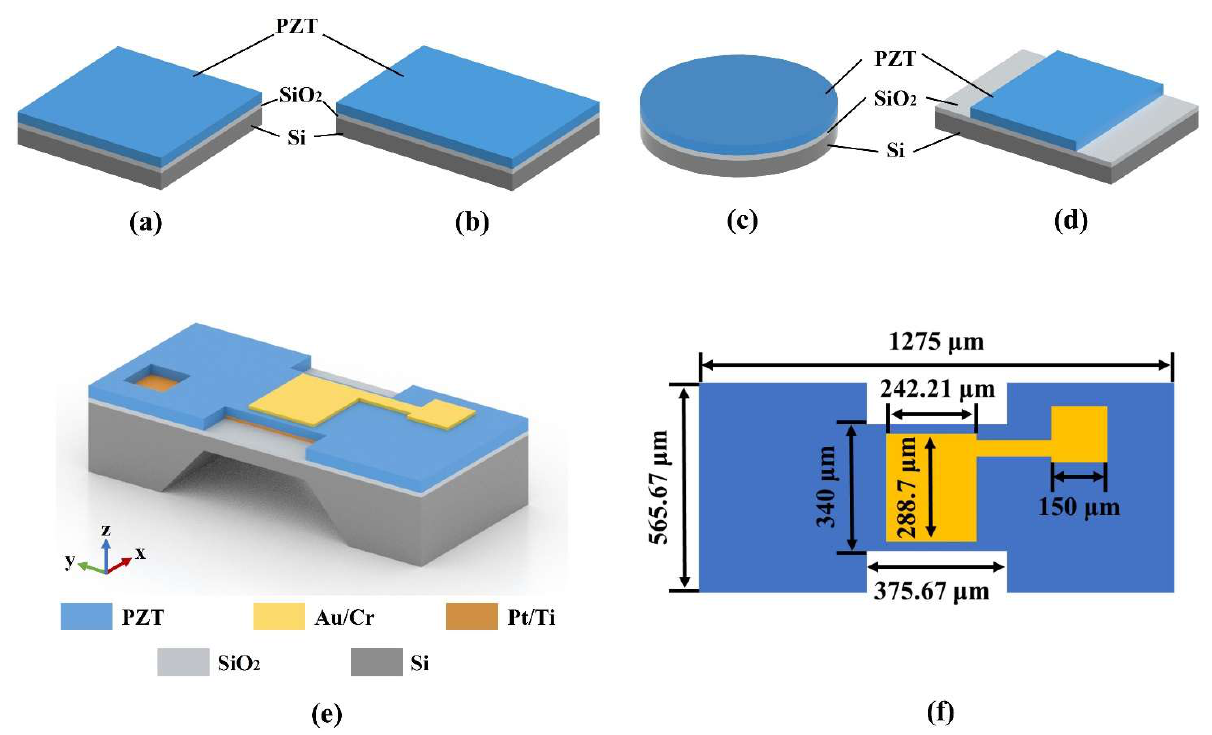
Figure 1. Schematic structure of pMUT’s composite diaphragm with ( a ) square; ( b ) rectangular; ( d ) circular; ( c ) I-shape. ( e ) Schematic structure of the pMUT with I-shaped composite diaphragm. ( f ) Structural parameters of the I-shaped diaphragm.